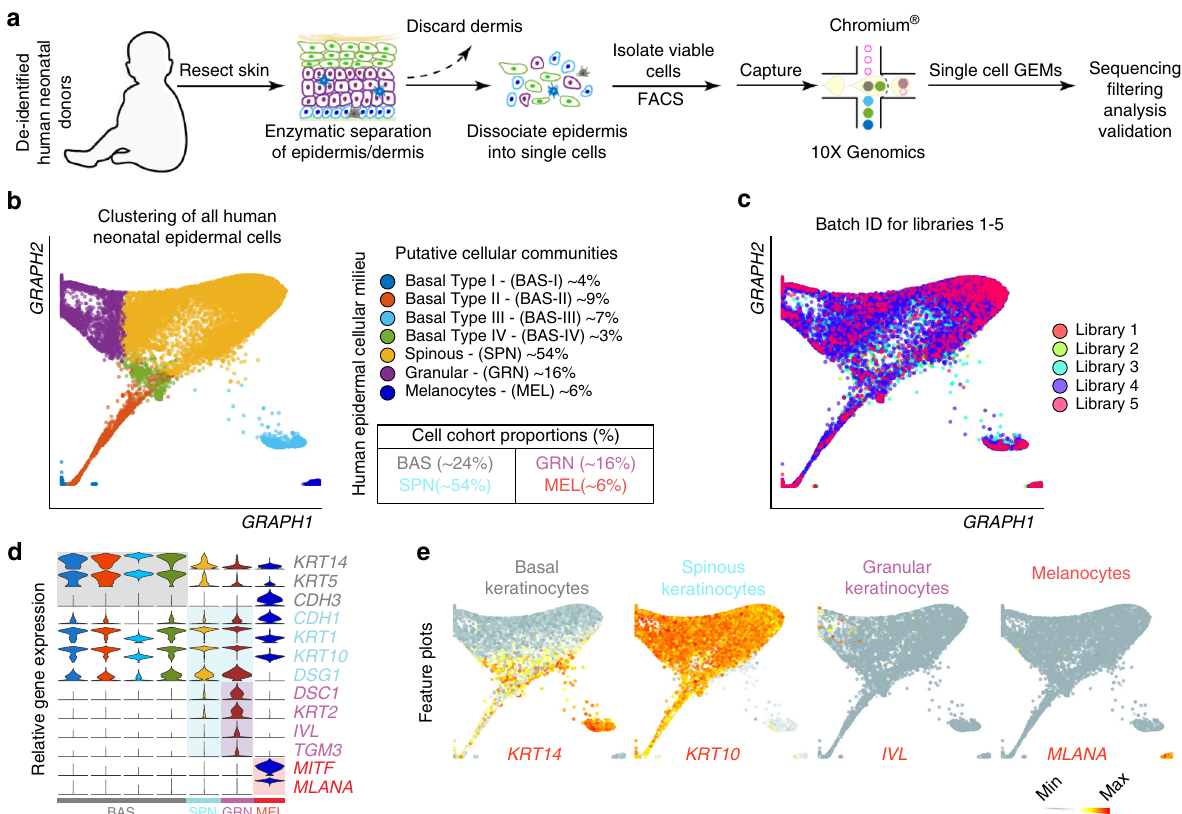
Fig. 1 De fi ning human neonatal epidermal cell populations using scRNA-seq. a Schematic of epidermal cell isolation from human neonatal foreskin. b Clustering of 16,360 single cells isolated from Libraries 1-5 that passed quality control metrics using SoptSC and displayed using Graph embedding. Cell proportions from putative cellular communities are quanti fi ed on the right. c Batch IDs for each library are superimposed onto the Graph embedded clusters and show no substantial batch effects. d Violin plots of relative gene expression of known epidermal marker genes split by cell cohorts using SoptSC. e Feature plots showing expression of keratinocyte markers from basal, spinous, and granular layers, including